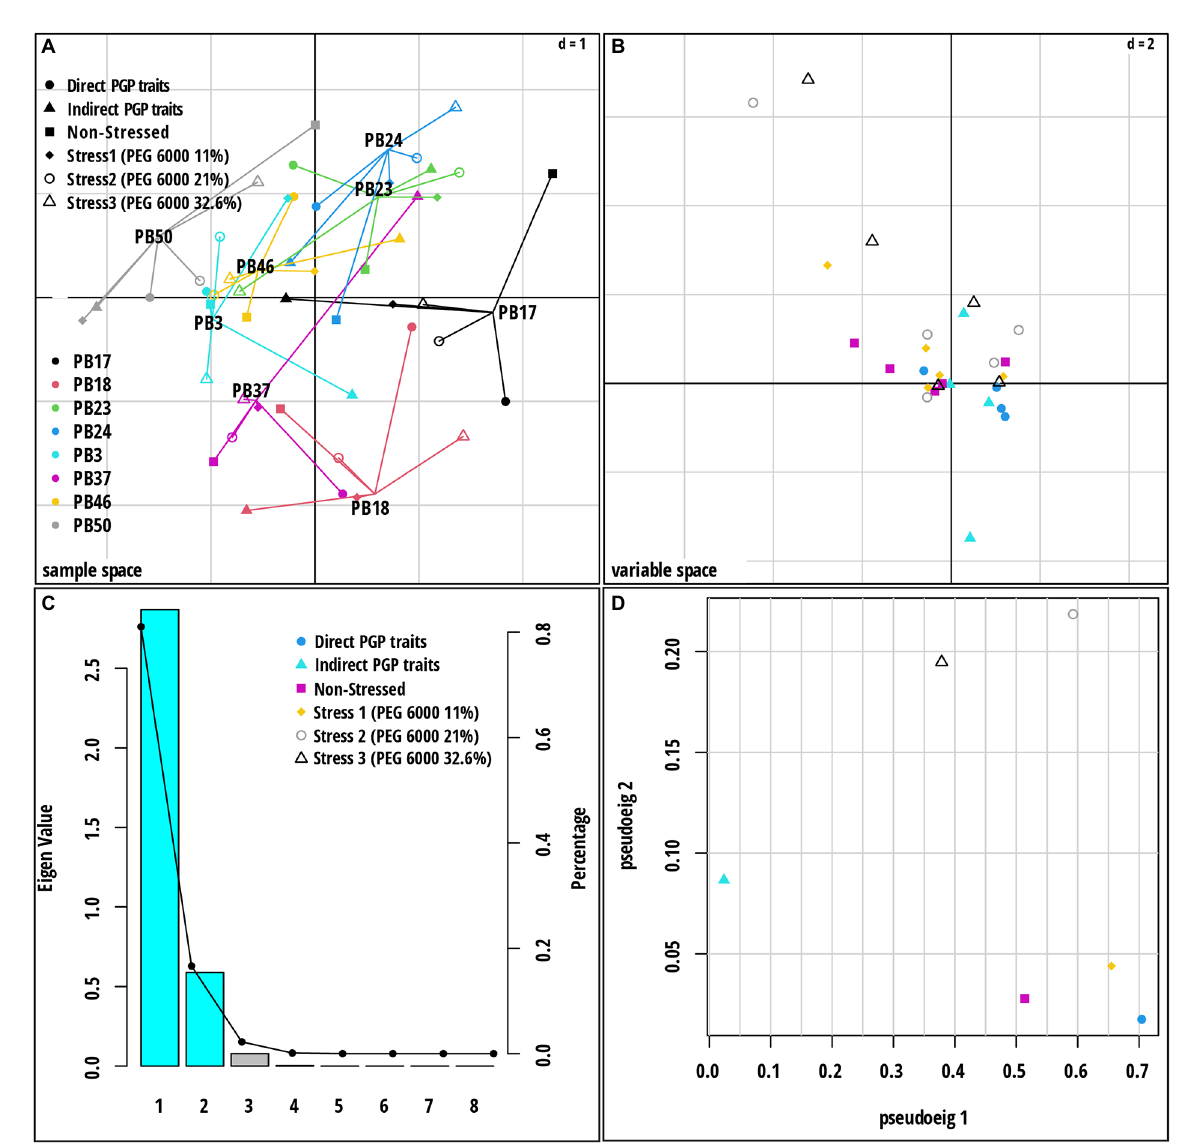
FIGURE 5 Multiple co-inertia analysis (MCIA) results based on six datasets [direct plant growth-promoting (PGP) traits, indirect PGP traits, microbial parameters under osmotic stress at PEG concentrations 0, 11, 21, and 32.6%]. (A) A plot of the first two components in the sample space. Each sample is represented by a shape where lines connect the six datasets for each sample to a center point (MCIA global score). (B) Variable space for each dataset. (C) A scree plot of absolute eigenvalues (bars) and the proportions of variance for the eigenvectors (line). (D) A plot of data weighting space that shows the pseudo-eigenvalues space of all datasets indicating the variance of an eigenvalue contributed by each dataset. The codes of the strains in plot (A) refer to the following strains: Bacillus endophyticus PB3, B . australimaris PB17, B . pumilus PB18, B . safensis PB23, Staphylococcus sciuri PB24, B . altitudinis PB37, B . altitudinis PB46, and B . megaterium